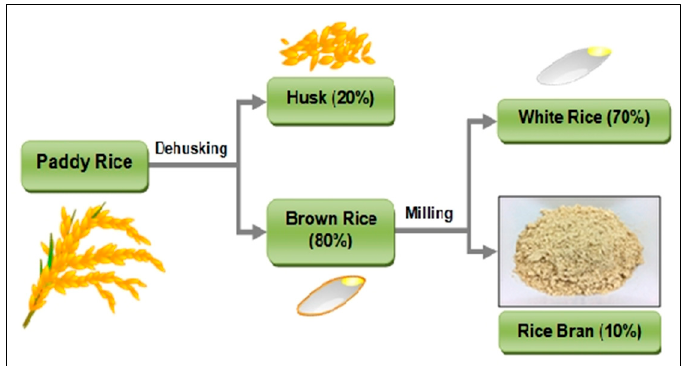
Figure 4. Paddy rice and its components.